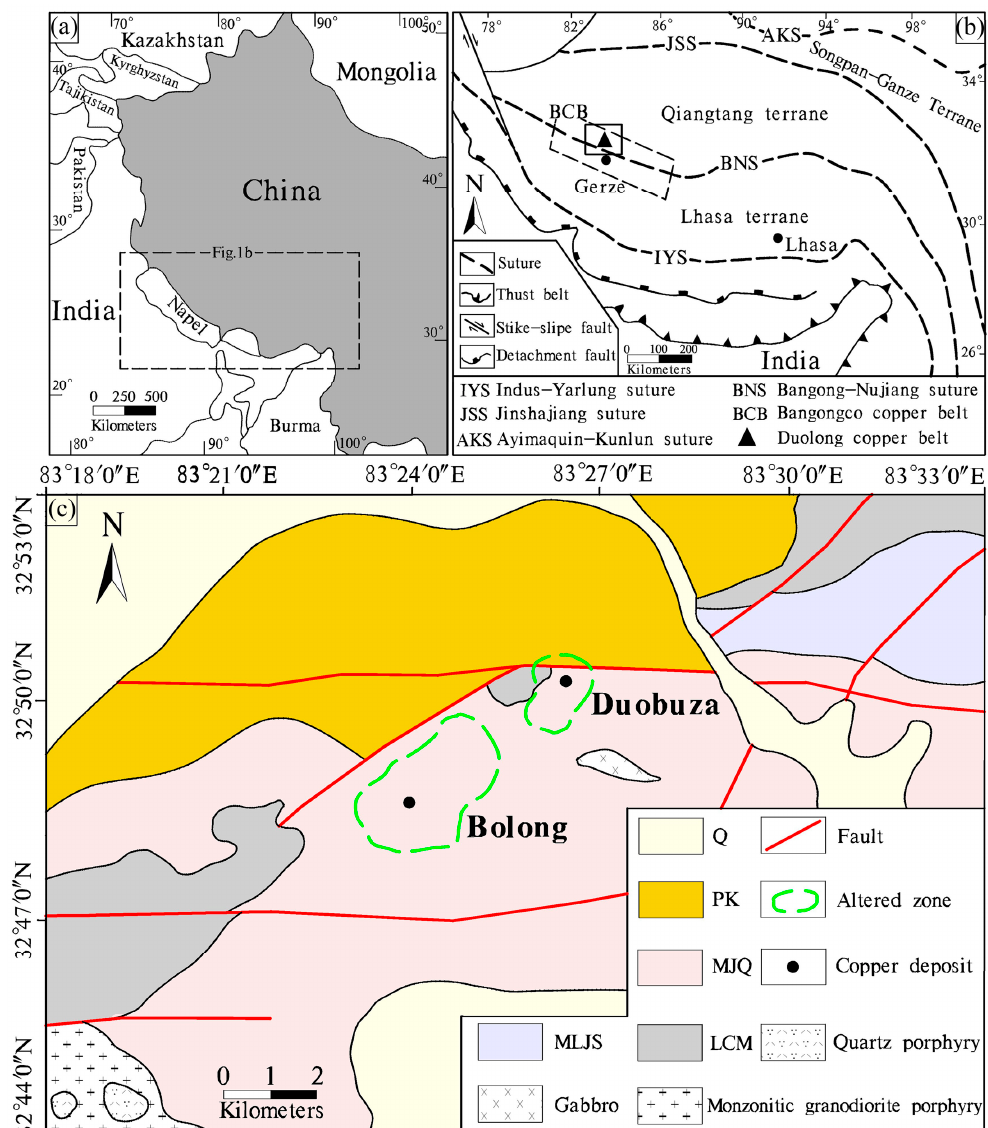
Figure 1. ( a ) Geographical map; ( b ) sketch tectonic map and generalized geologic map; ( c ) the Duolong PCD (Modified from [55]).